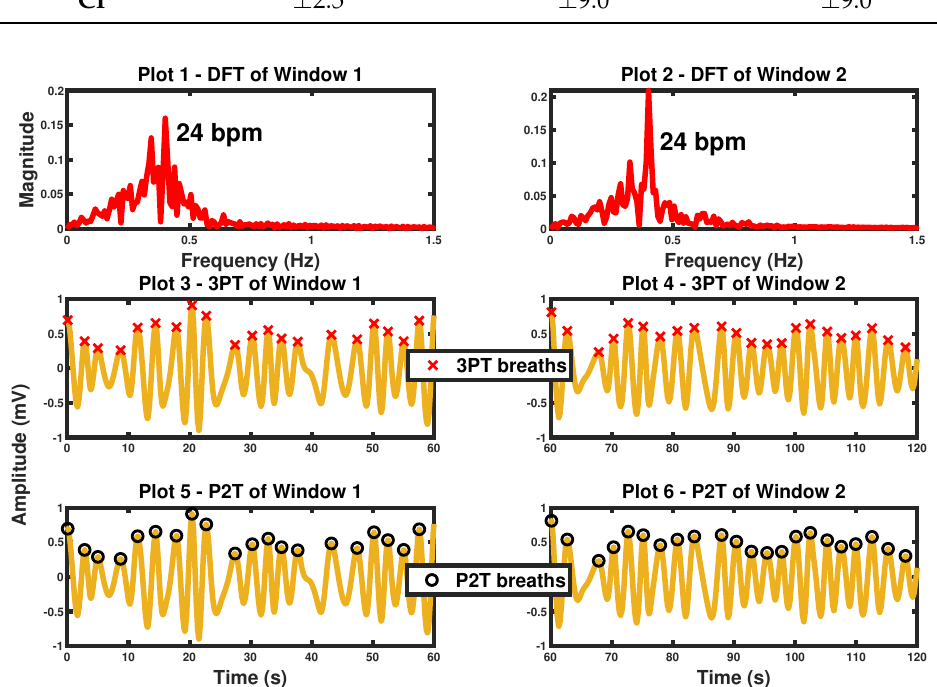
Figure 8. DFT and TD analysis of the EMDDR signal of b001: Plots 1 and 2 depict the DFT analysis of the first two respiratory windows (DFT points = 300,000). Plots 3 and 4 show the identified breaths (red crosses) by the 3PT analysis. Plots 5 and 6 represent the identified breaths (black circles) by the P2T